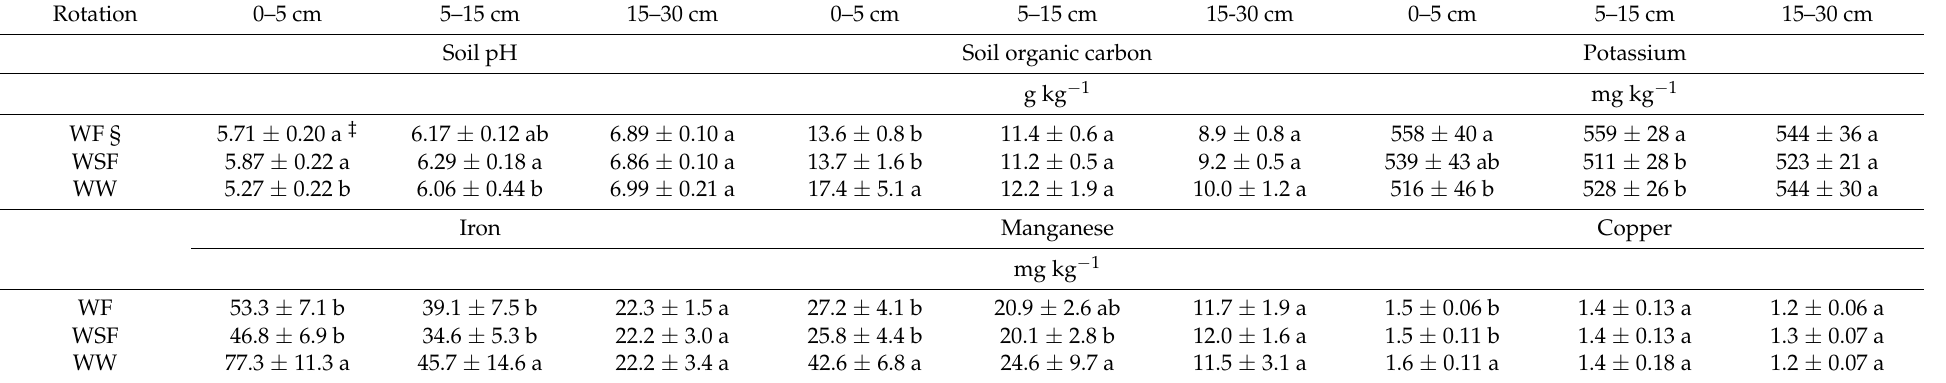
Table 3. Soil organic carbon, pH, potassium, iron, manganese, and copper concentrations as affected by crop rotation and soil sampling depth.